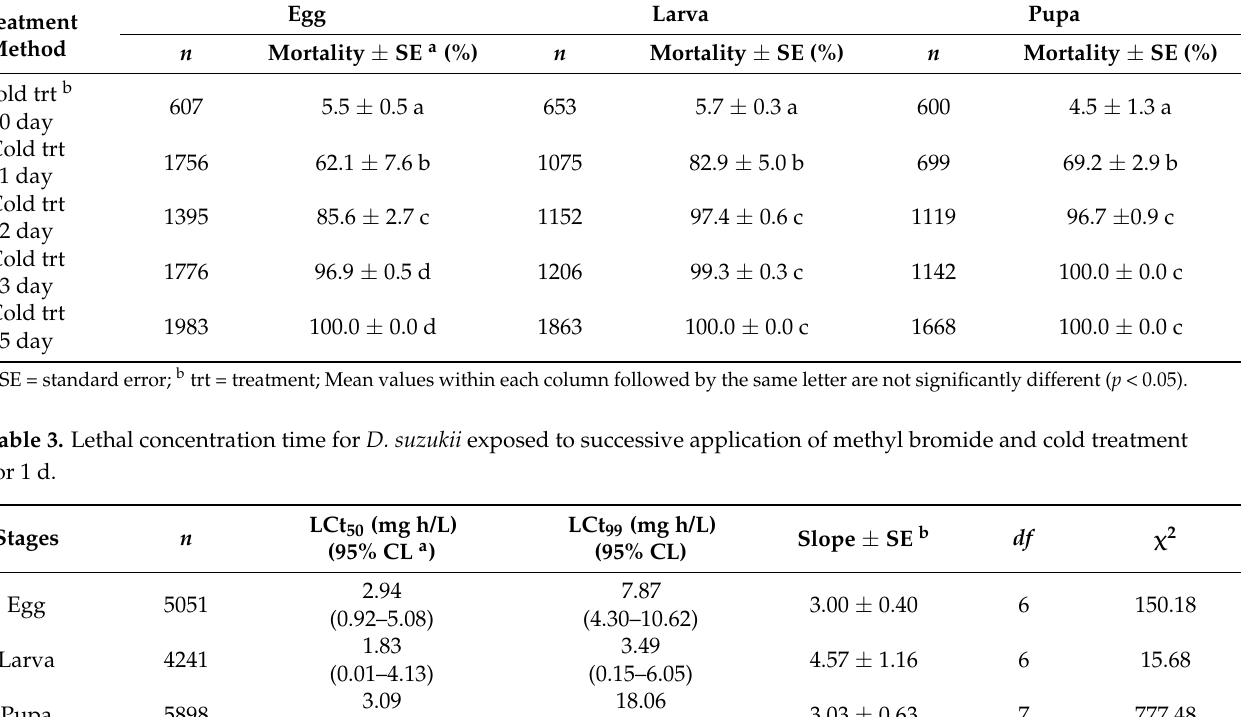
Table 2. Mortality of D. suzukii exposed to cold treatment (0 ◦ C) for 0, 1, 2, 3, 5 d in cold chamber. Treatment